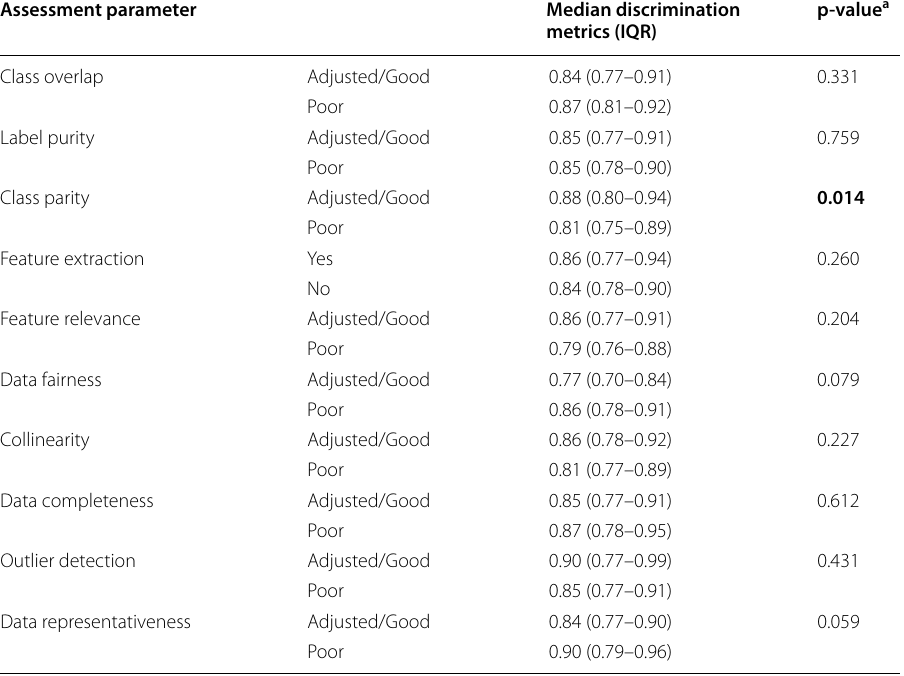
a Mann Whitney U test used for analysis p-value in bold is statistically significant